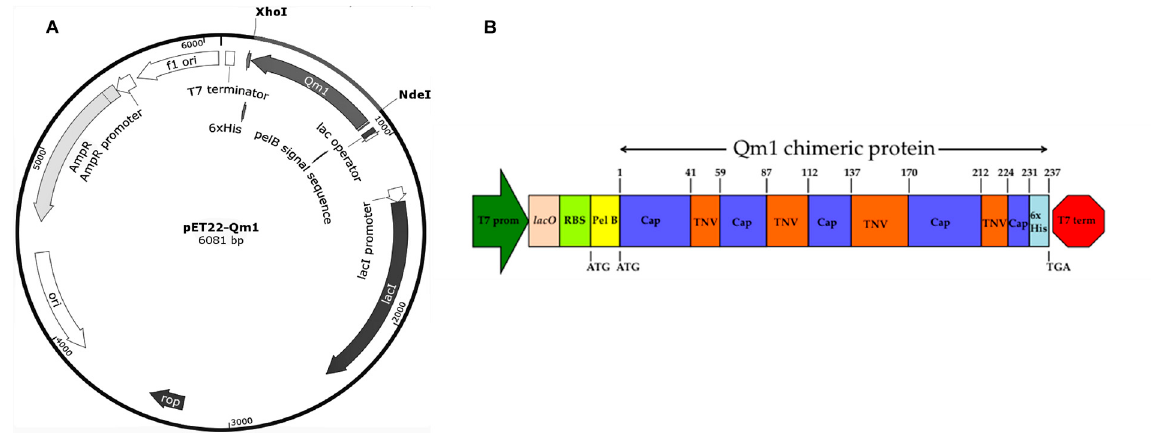
Figure 5. pET22-Qm1 expression plasmid and the genetic engineering design of the chimeric Qm1. ( A ) The Qm1 gene synthesized by GeneScript and inserted between the X ho I-N de I restriction sites in pET-22b to obtain the pET22-Qm1 final expression vector. ( B ) The genetic engineering design of the chimeric Qm1 protein coded into a bacterial expression cassette. The expression cassette into pET-22b+ shows the T7 promoter in green, and the T7 terminator in red. After the promoter, the genetic elements are the lac operator in pink and the ribosome binding site (RBS) in light green. The pel B leader sequence in yellow is fused to the chimeric protein (Qm1) with the tobacco necrosis virus (TNV) backbone in orange that possess Cap epitopes in blue.